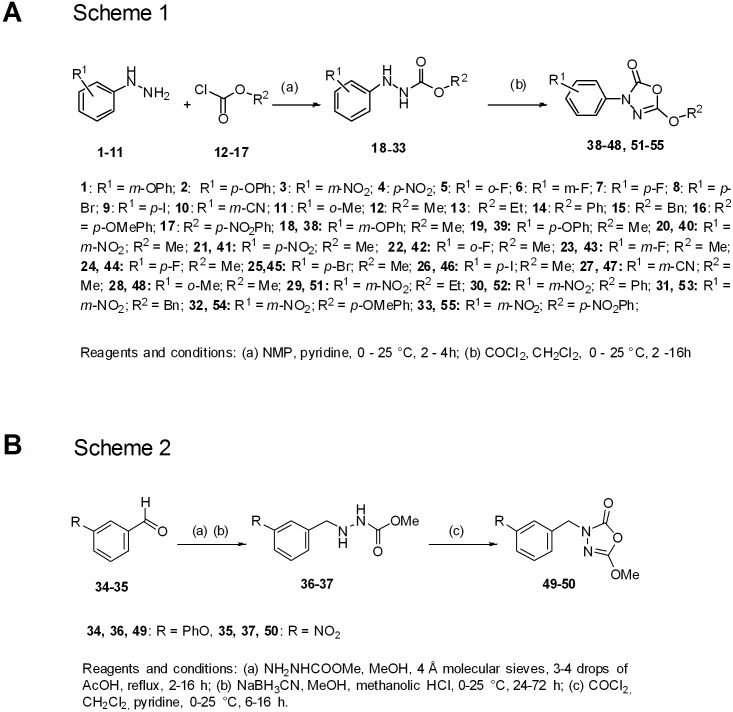
Schemes outlining the synthesis procedures for the C7600 analogues of this study.